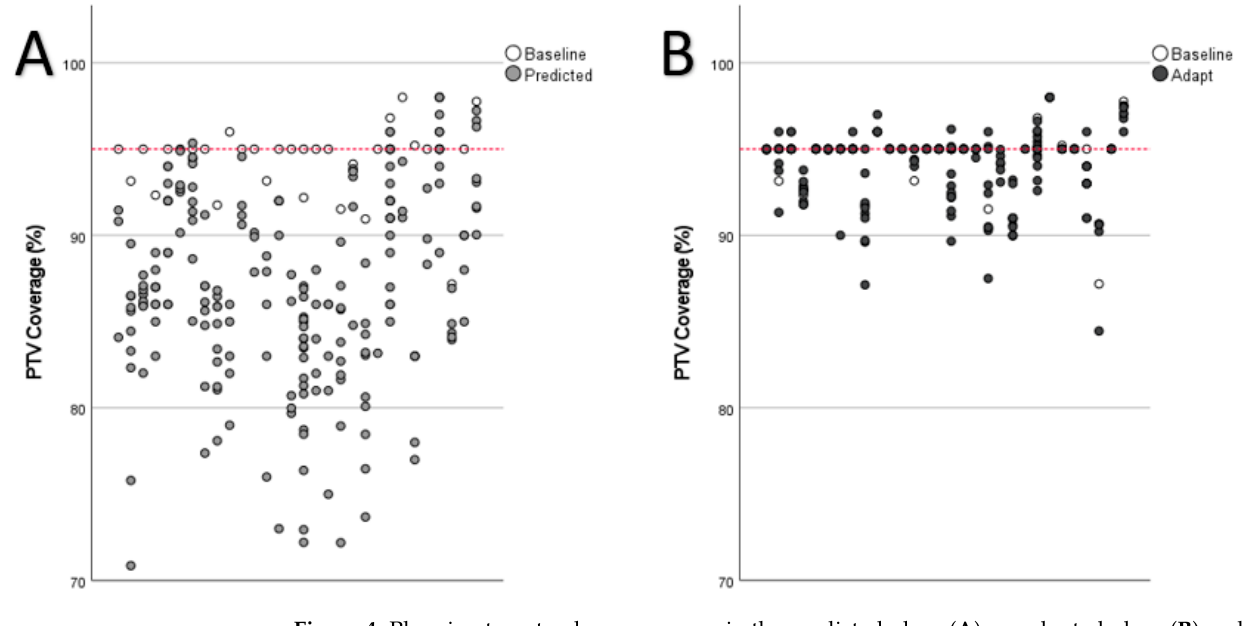
Figure 3. Planning target volume coverage (PTV) and biologically effective dose (BED). ( A ) PTV coverage. The dashed line represents the aimed 95% coverage. ( B ) BED * covering 95% of the PTV (D95). The dashed line represents 100 Gy BED. * α / β = 10 for the liver metastases.